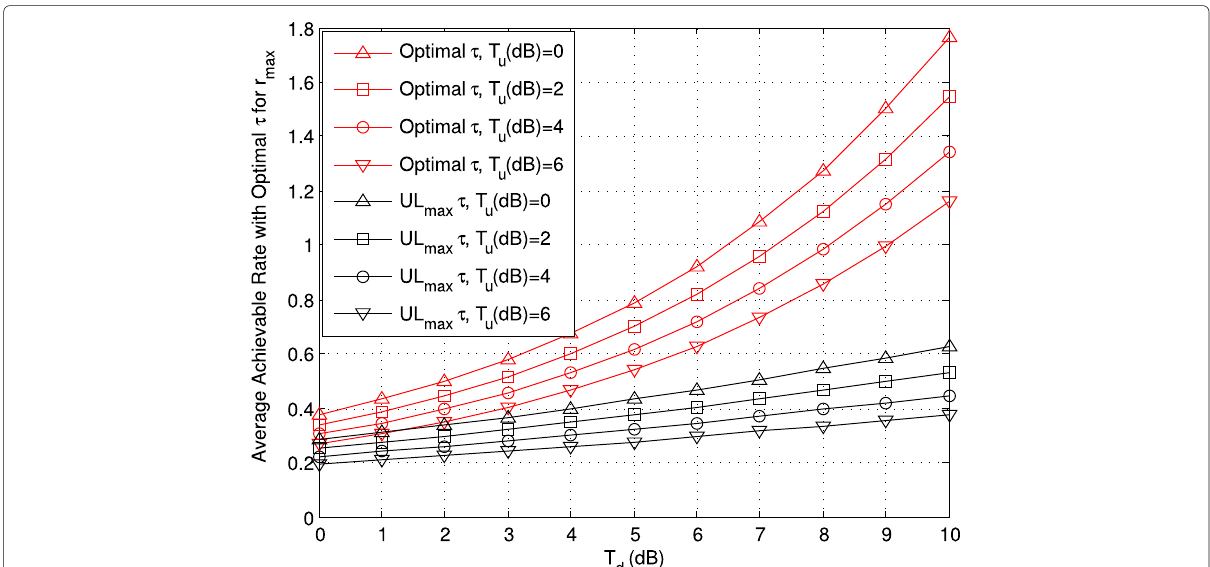
Fig. 8 Average achievable rate with the optimal τ for varying T d with different T